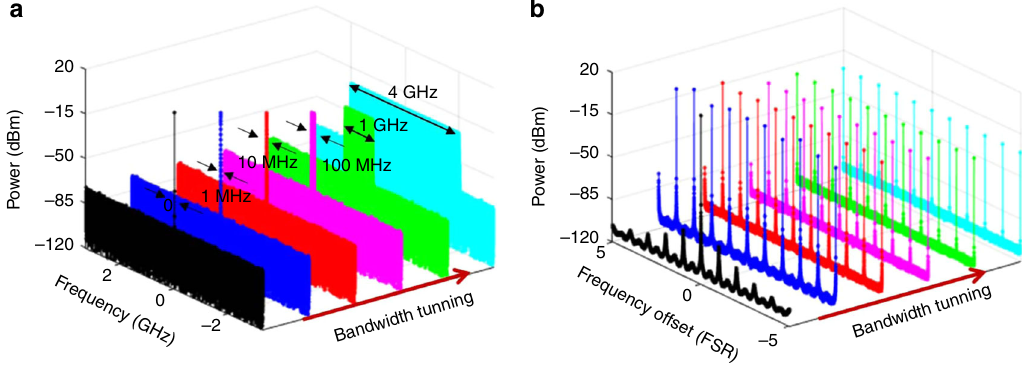
Fig. 5 Frequency scanning bandwidth vs output power level. a Power spectrum when the scanning bandwidth is tuned from 0 to 4 GHz. b Zoom-in views of power spectrum when the scanning bandwidth is tuned from 0 to 4